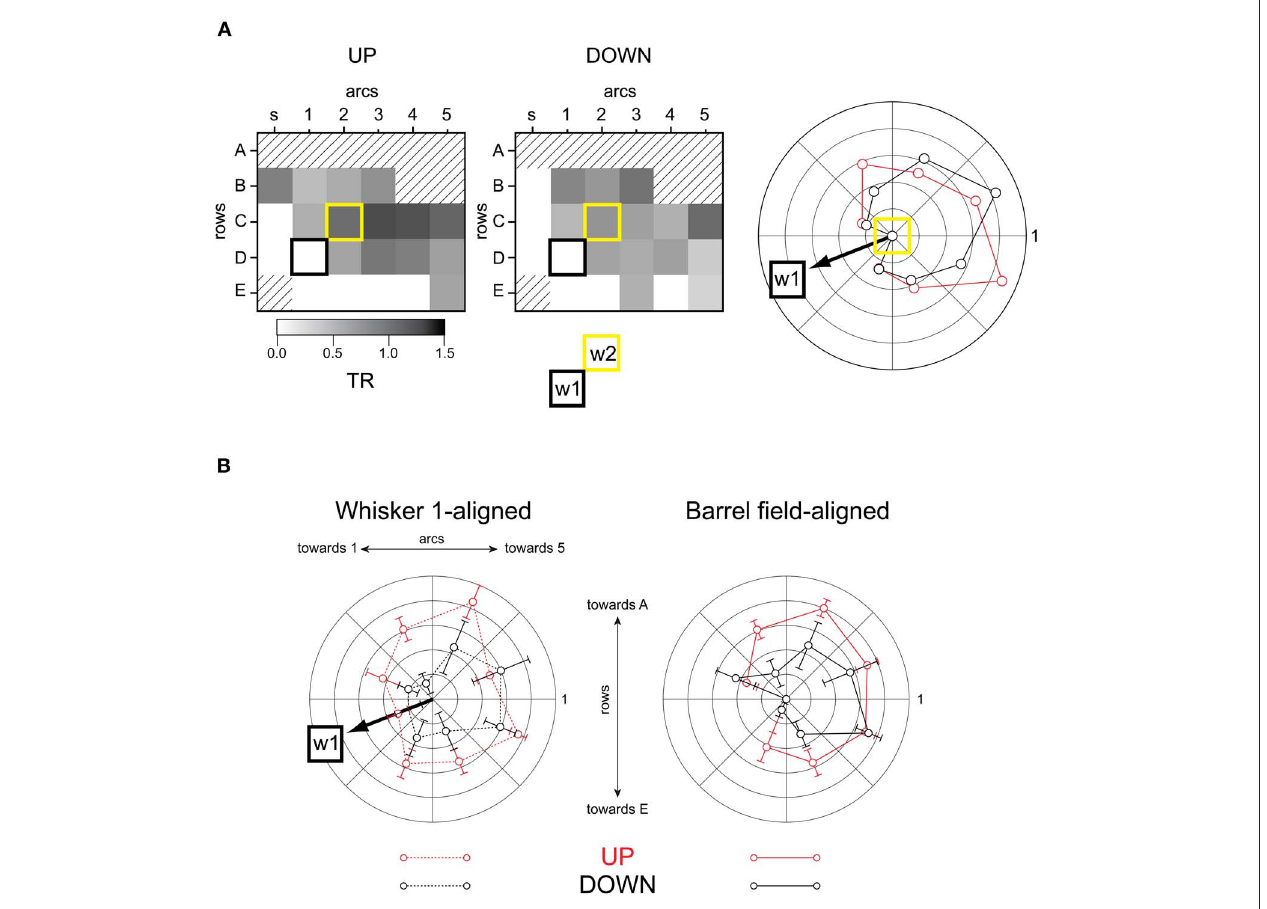
suppression (see Results). (B) Population measurements of suppression by angle (TR). Left: up-state vs down-state, angles aligned to whisker 1. Right: up-state vs down-state, angles aligned to barrel field. The outer radius of the polar plot corresponds to a TR of 1, indicating no suppression (see